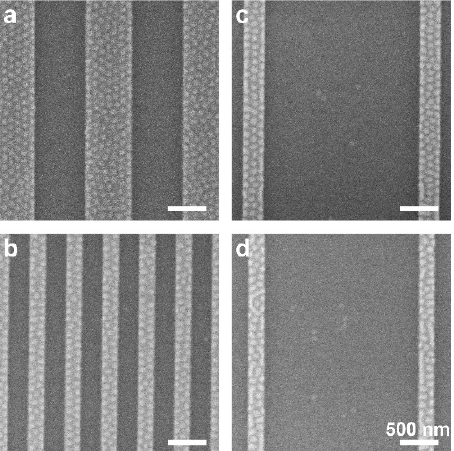
Figure 3. ( a – d ) SEM images of films cast on substrates featuring 20 nm-deep trenches, showing patternless trenches and dot-patterned plateaus. Nominal film thickness is 23 nm. Trench/plateau lateral widths: ( a ) 640/640, ( b ) 240/240, ( c ) 2000/320, and ( d ) 2000/240 nm. Bright and dark stripes correspond to the plateaus and trenches, respectively. All scale bars represent 500 nm. The image shown in panel ( c ) was adapted with permission from Ref. [36] (copyright 2019 American Chemical Society).